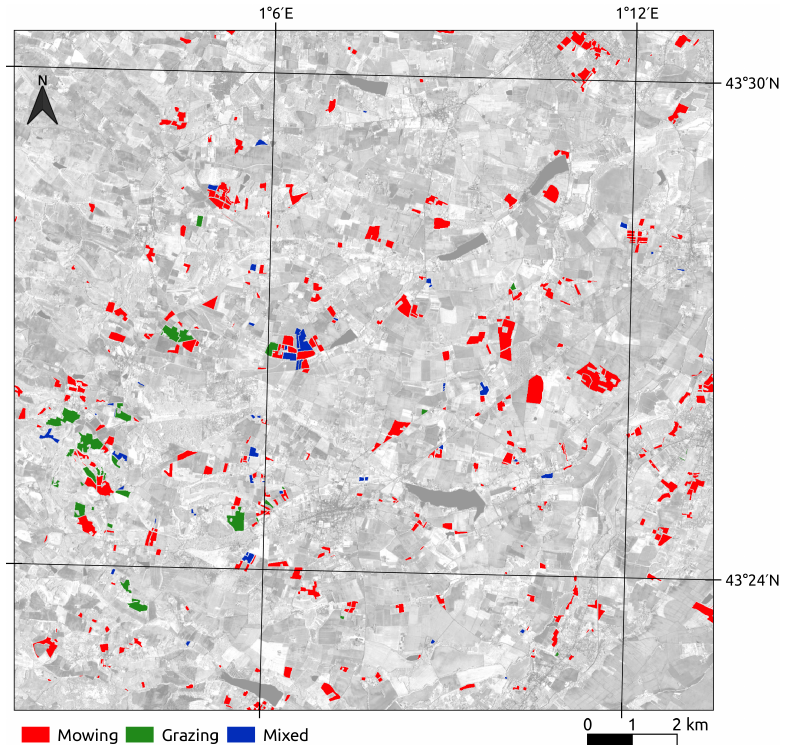
Figure 13. Extract of the management practices classification of the grasslands from the French agricultural land use database (Registre Parcellaire Graphique) in 2014. The background is a May, 2014 Formosat-2 image in the NIR